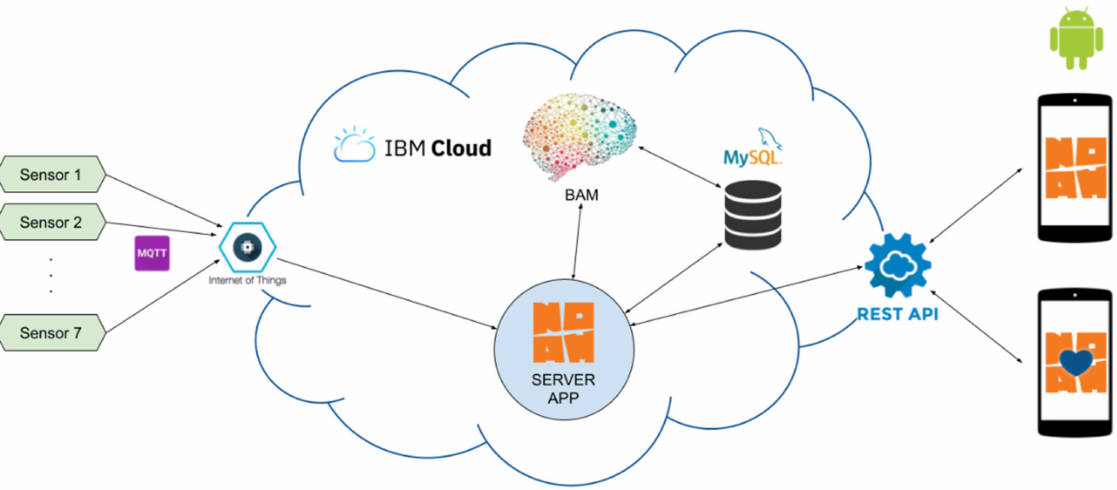
Figure 2. The architecture of the prototype system.